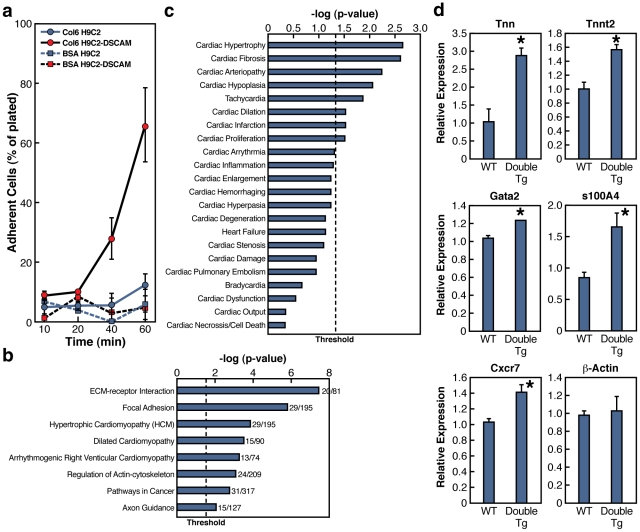
DSCAM and COL6A2 enhance cell adhesion and induce transcriptional changes.a) Cell adhesion assay in a cardiomyocyte cell line. A stable line of H9C2 cardiomyocyte cells expressing DSCAM (H9C2-DSCAM) or parental H9C2 cells were grown on BSA or COL6 coated plates. At the indicated time points, plates were gently washed and the number of cells retained on the plates was determined shown as percent of cells adhering to plates. b) The top gene ontology KEGG pathway terms of differentially expressed genes identified by RNA-seq of H9C2 and H9C2-DSCAM cell lines grown on COL6 coated plates. Threshold shown p<0.05. c) Enriched heart related gene ontology terms in H9C2 vs. H9C2-DSCAM differentially expressed mRNAs using Ingenuity knowledge pathway database. Threshold shown p<0.05. d) qRT-PCR of select genes in wild type and double transgenic e14.5 hearts. Results shown as average +/− SEM (N = 3). Unpaired two-tailed t-test analysis p<0.05 (*).